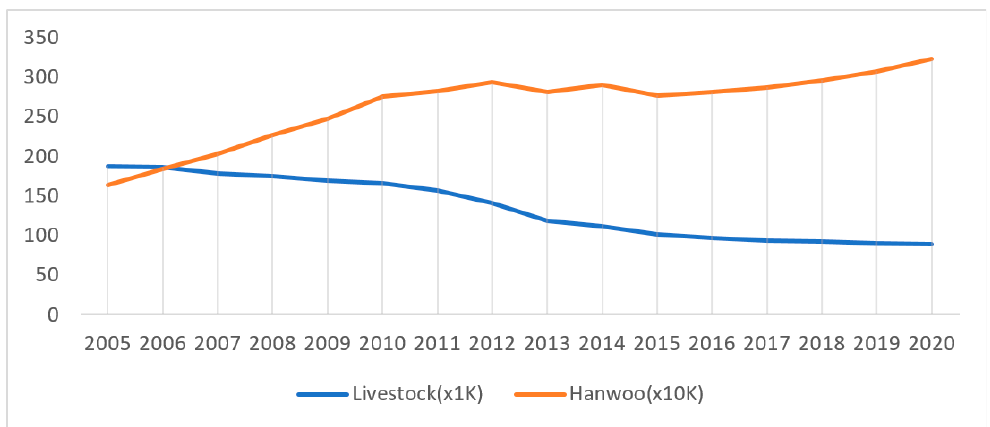
Figure 1. Changes in Hanwoo breeding farms and the number of Hanwoo in Korea.